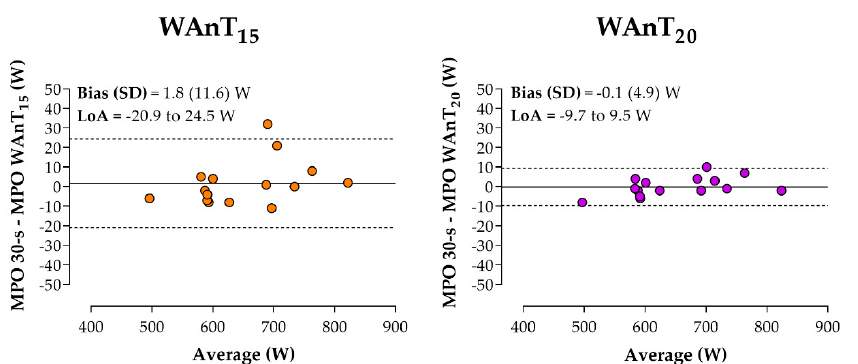
Figure 3. Cross-validation analysis. Bland–Altman plots comparing the MPO estimated by the 15 s (WAnT 15 ) and 20 s (WAnT 20 ) models, and the 30 s MPO (reference criterion). LoA: limits of agreement (LoA = bias ± 1.96 SD).